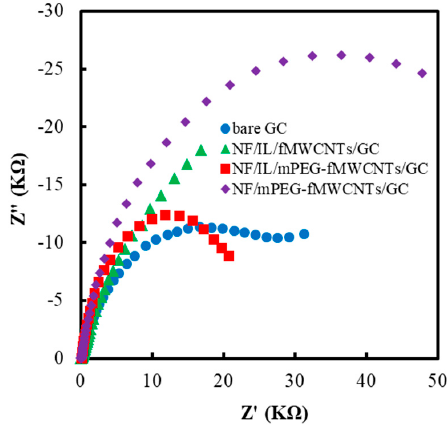
Figure 10. Electrochemical impedance spectroscopy (EIS) of different polymers modified GCE. The experiments were carried out at − 0.30 V potential from 0.1 Hz to 10 kHz with a modulation voltage of 5 mV in PBS (50 mM, pH 7.0) containing 5 mM redox couple solution ([Fe (CN) 6 ] 3 − /4 − ) and 0.1 M KNO 3 at 25 °C.